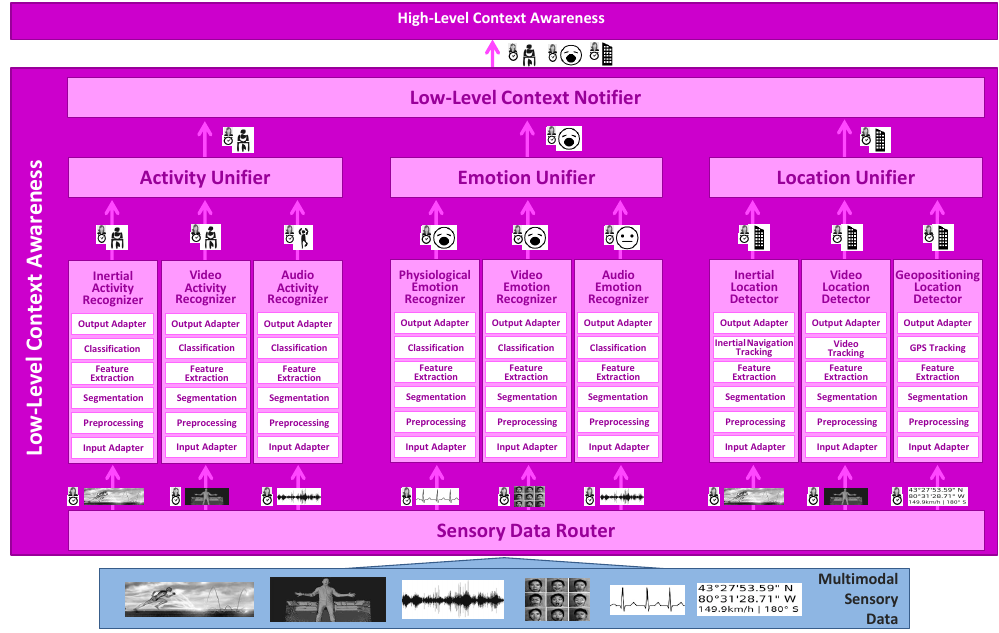
Figure 2. Low-Level Context Awareness operation